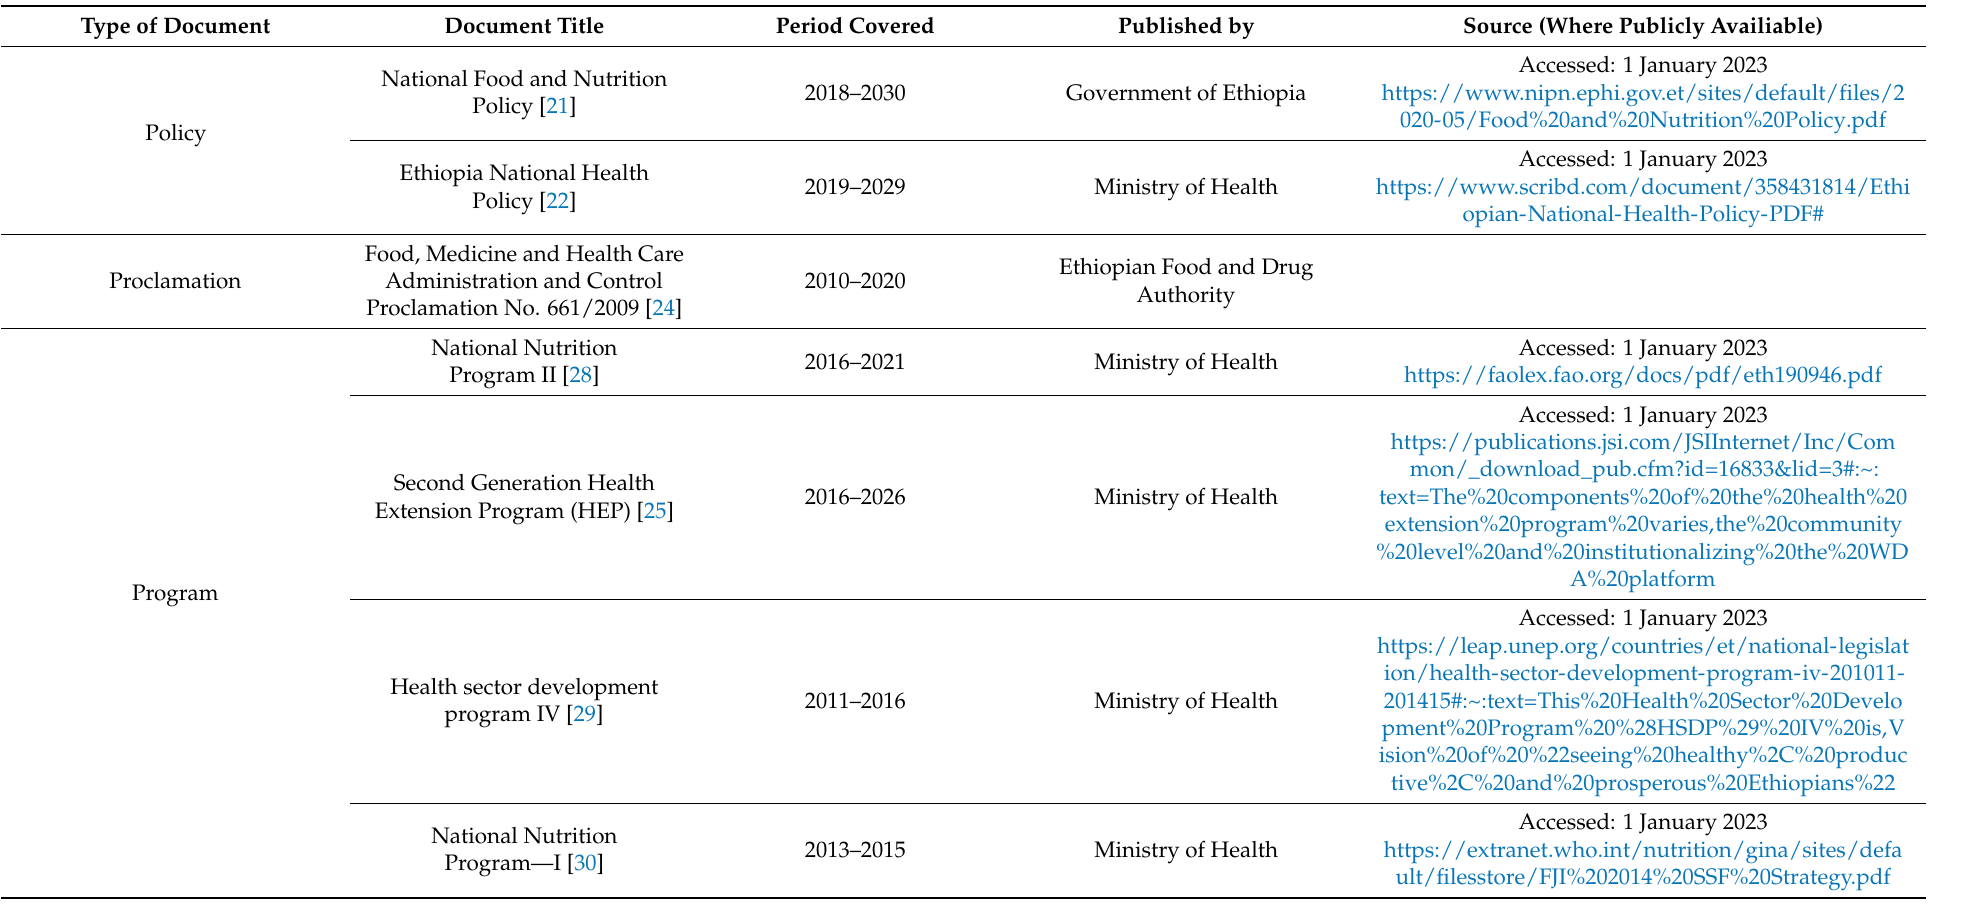
Table 1. List of analyzed documents in this study (number in parenthesis refers to endnotes), 2021 ( n =